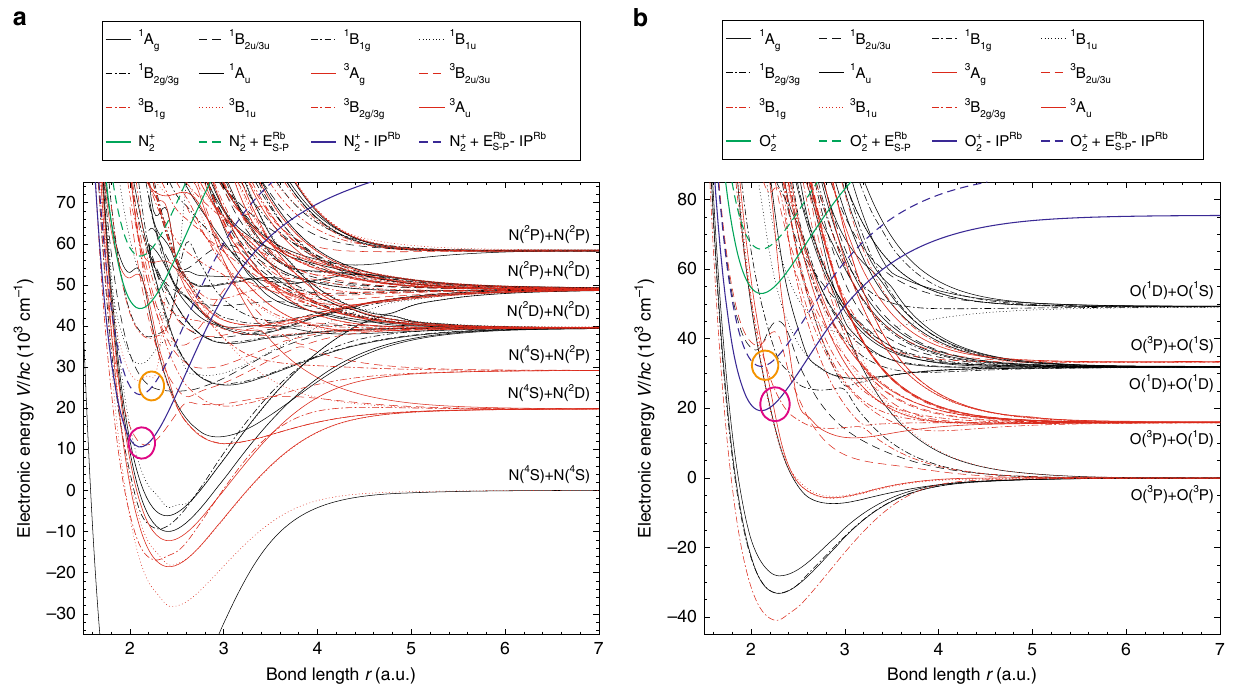
Fig. 4 Potential energy curves. Potential energy curves for a N 2 and b O 2 and their respective ions as a function of the bond length r . The states have been classi fi ed within D 2h symmetry. The curves for the relevant cationic ground states are indicated by solid green lines, the cationic curves shifted by the ionisation potential of Rb by the solid blue lines. Dashed lines represent the corresponding curves offset by the excitation energy to the Rb ( 2 P Circles indicate relevant crossing points promoting non-adiabatic transitions between the surfaces.